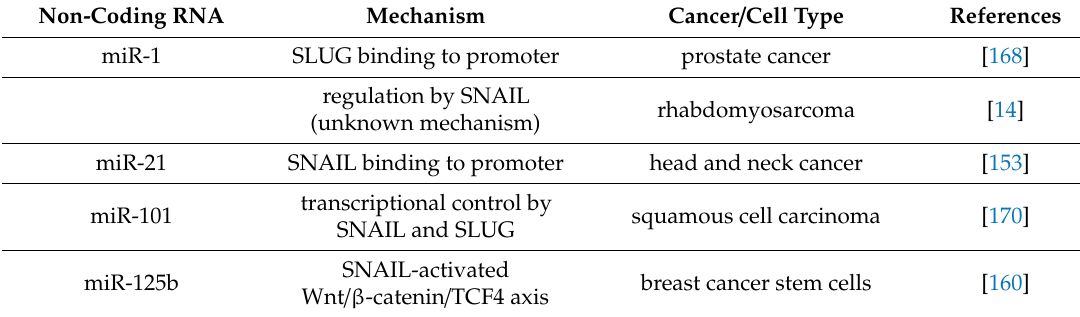
Table 5. Non-coding RNAs regulated by SNAIL and